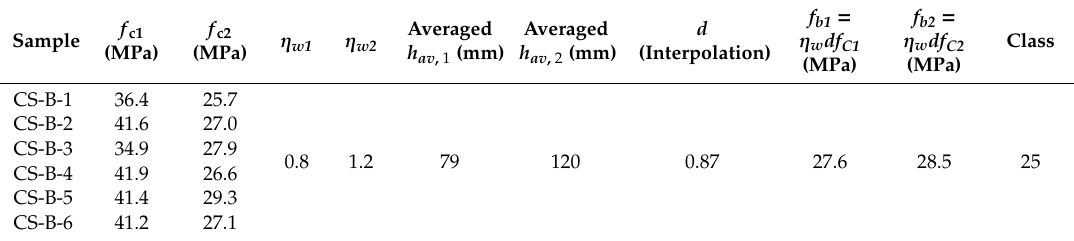
Table 6. The results obtained from the compressive strength tests carried out on the CS-B specimens used to convert to the strength class of the